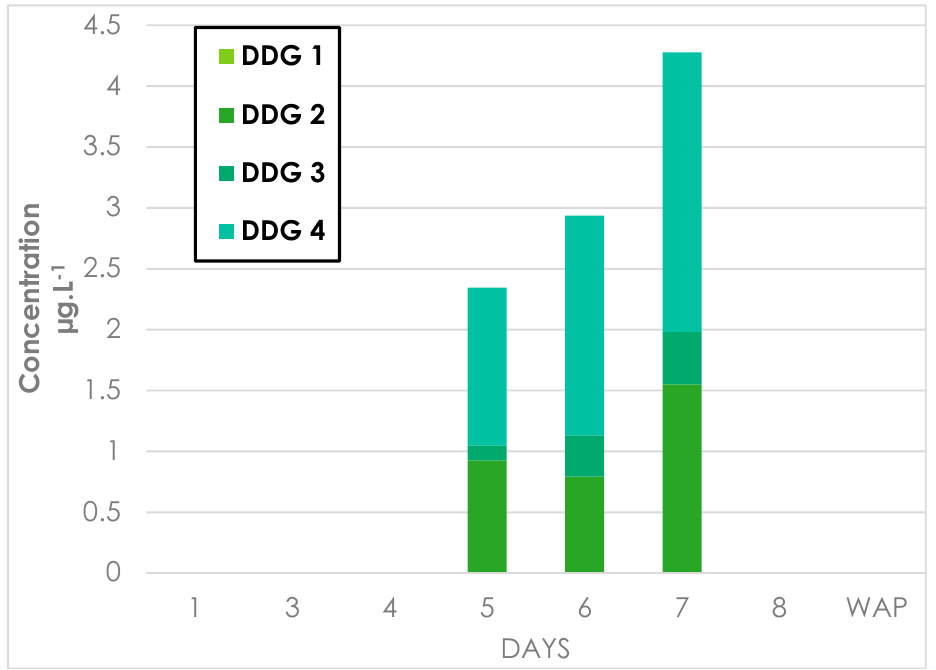
Figure A4. Evolution of DDG isomers during Syrah fermentation.